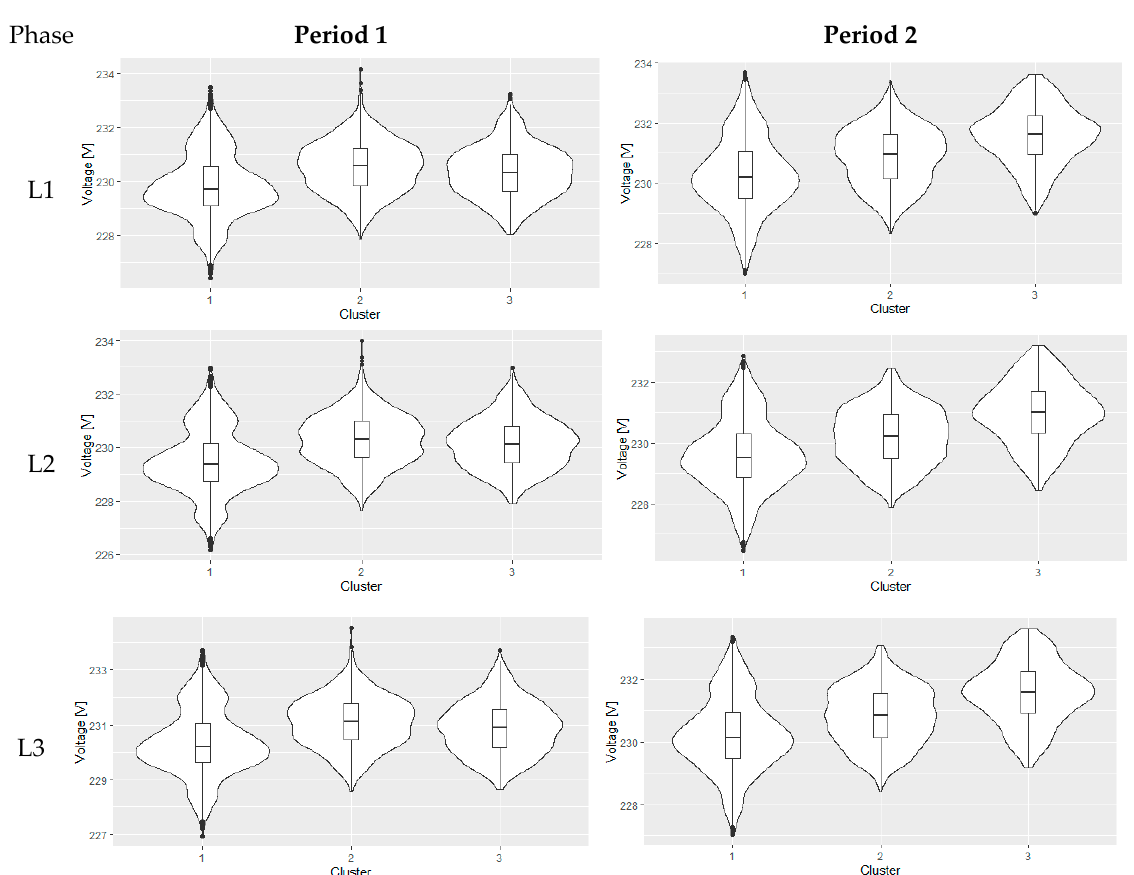
Figure 8. Violin plots of voltage comparing clusters for Period 1 and Period 2 in each phase.